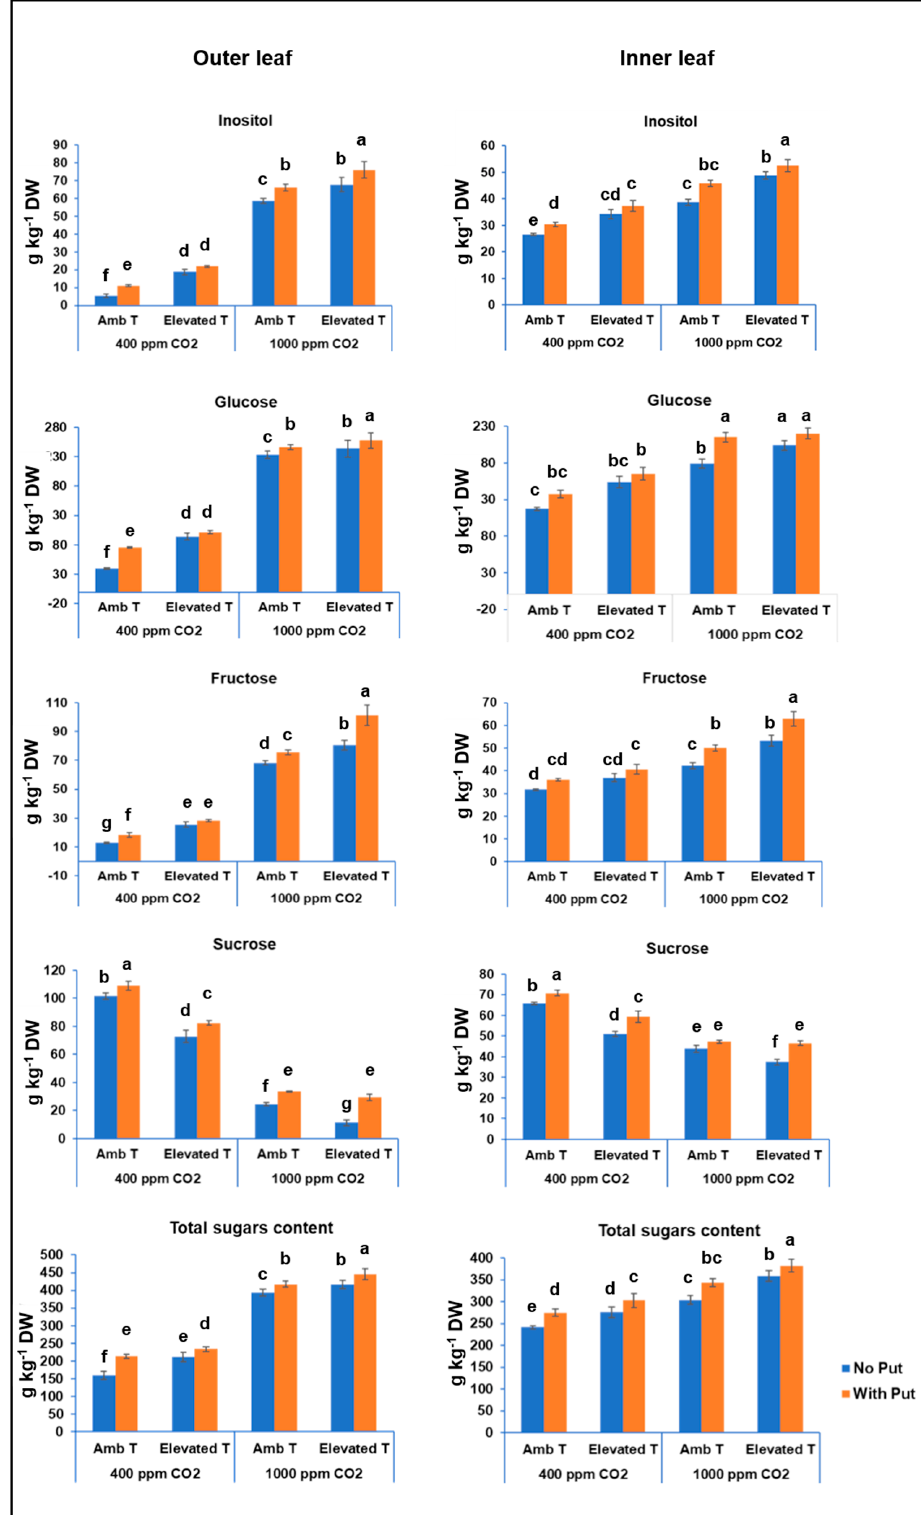
Figure 3. The effect of the foliar application of putrescine on the concentrations of sugars (g kg − 1 DW) in outer and inner leaves of the cauliflower cv. Moonshine at different CO 2 concentrations and temperatures. The data are presented as the treatment means ( n = 5). Different small letters represent significantly different mean values according to Tukey’s test at p ≤ 0.05.